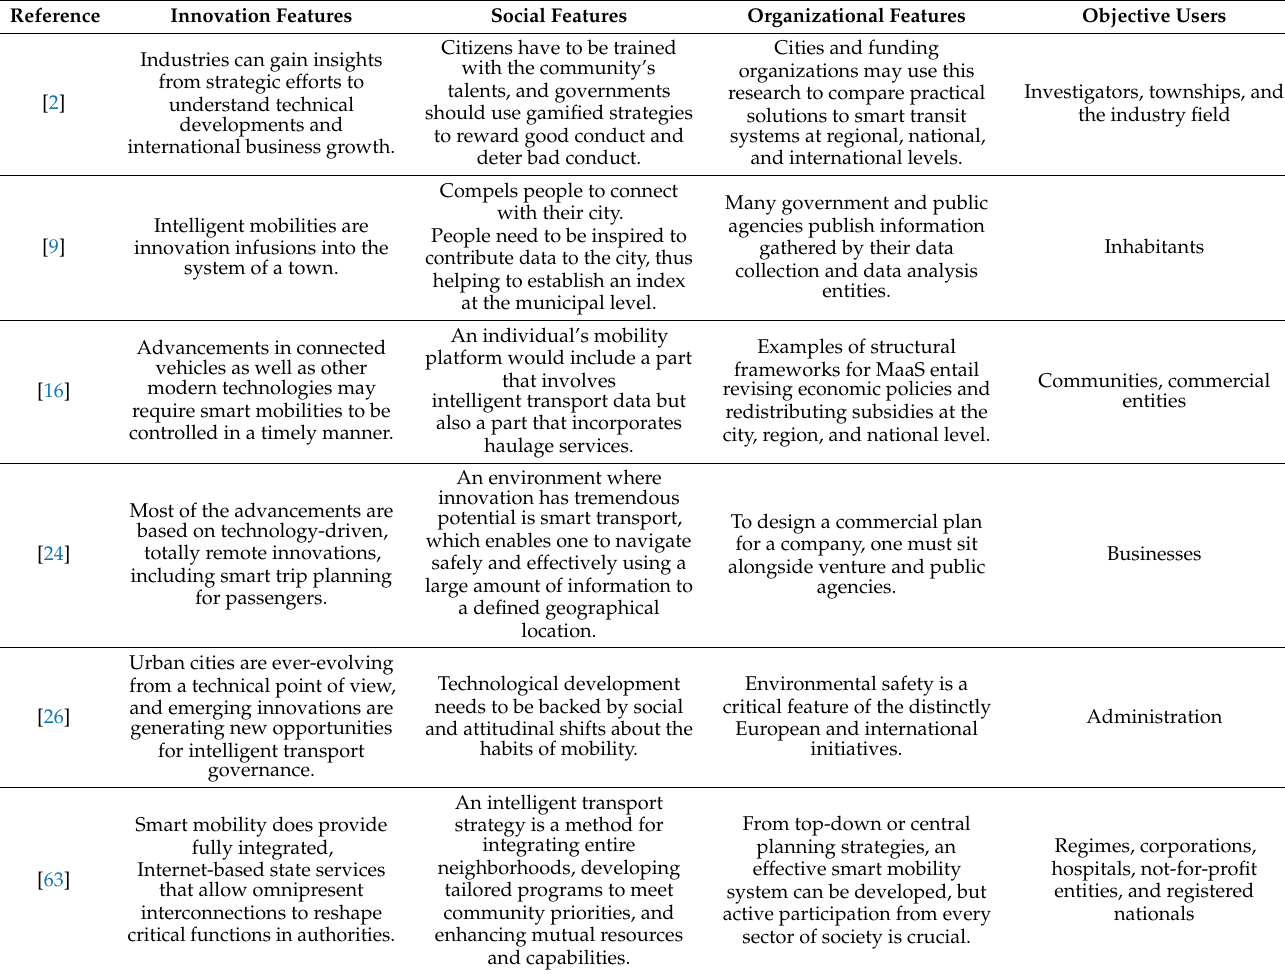
Table 7. Conceptualization of smart mobility with technological, human, and institutional dimensions.